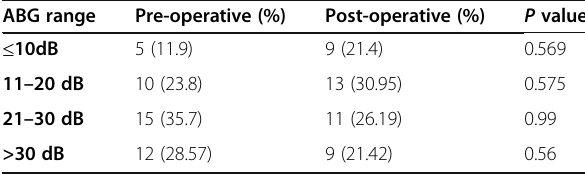
Table 3 ABG range in strata of 10dB ( n